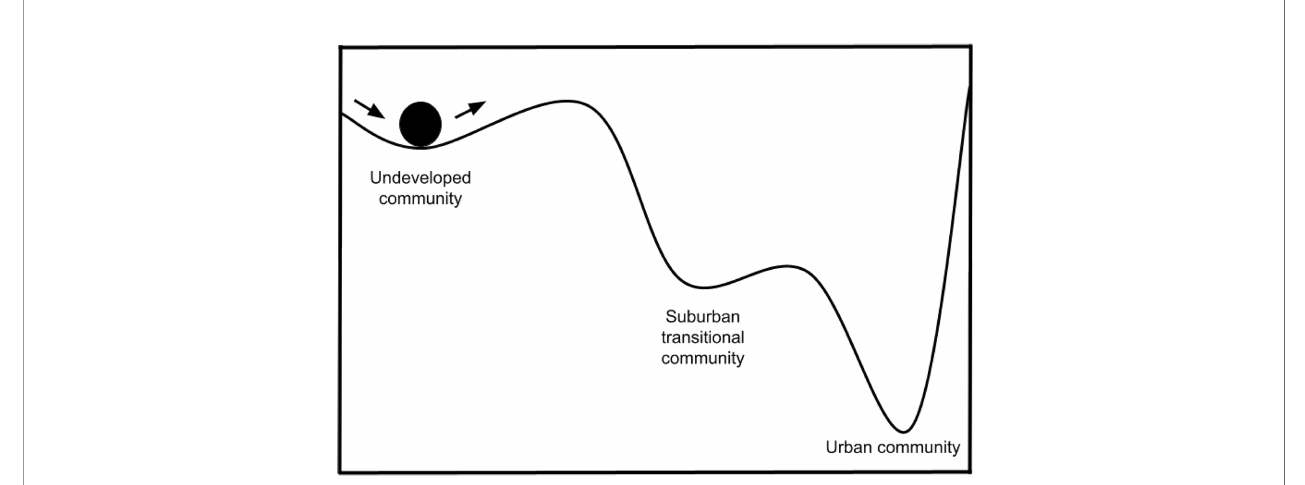
FIGURE 3 | Conceptual diagram of resilience in urban habitats, illustrated by a ball-cup analogy and loosely modeled after Figure 1 of Gunderson (2000). Communities in undeveloped habitats have little resistance to urban conversion and are quickly converted to suburban, then urban communities (although the suburban state can be skipped). Urban communities then require signi fi cant energy input to transition to another community state (e.g., through habitat restoration, shown by the steep rightward slope) or to recover to the original, pre-urbanization community (i.e., the steep leftward slope). In most instances recovery to the original community is not observed because urban habitats are rarely reverted to natural, undeveloped states. The steepness of these slopes may decrease with the use of green infrastructure and other habitat improvements, allowing an urban community to transition to a suburban state or a new, semi-urban